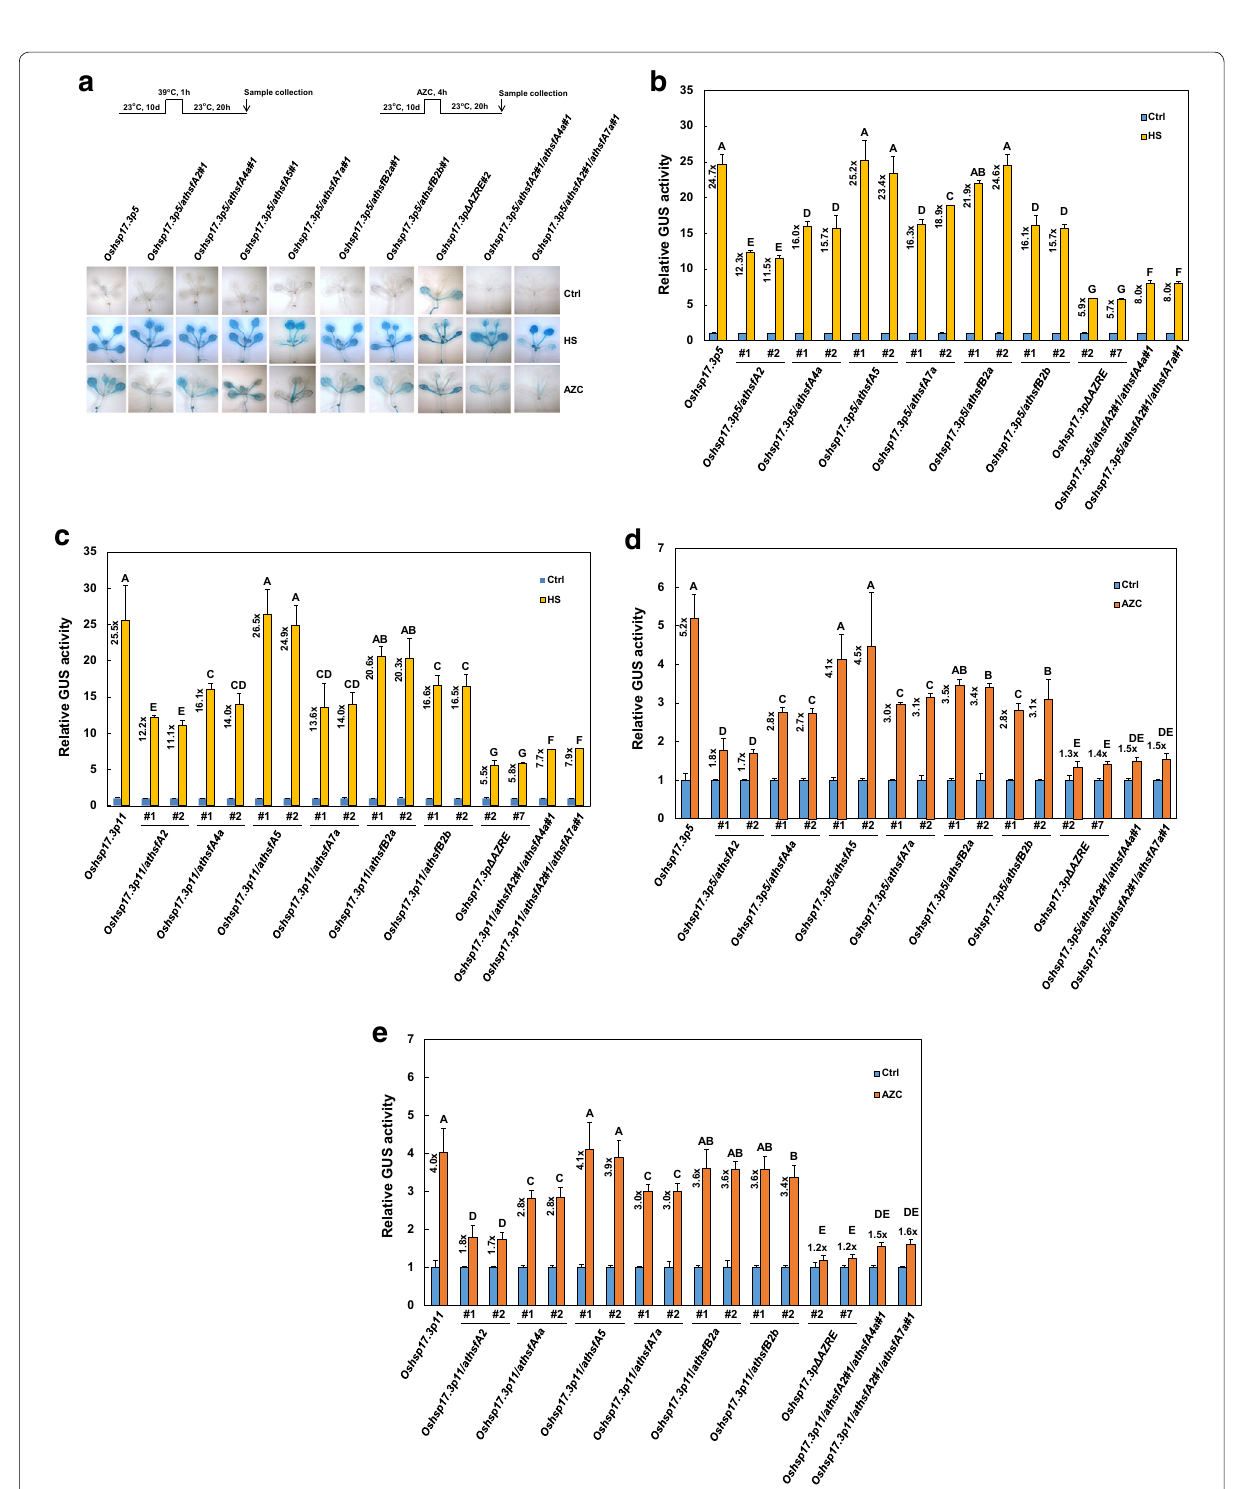
Fig. 2 Analysis of HS and AZC responsiveness of AtHSF mutants by GUS staining. AtHSF mutant plants were transformed with a chimeric Oshsp17.3Pro::GUS gene as described. a Seedlings from independent transgenic lines underwent HS or AZC treatment as indicated and GUS histochemical staining. Non‑stress control condition (Ctrl). Relative GUS activity of seedlings treated with b , c HS and d , e AZC. Data are mean GUS activity relative to that of the Ctrl from three independent experiments and the fold expression is indicated. Bars with the same letter are not significantly different at P <